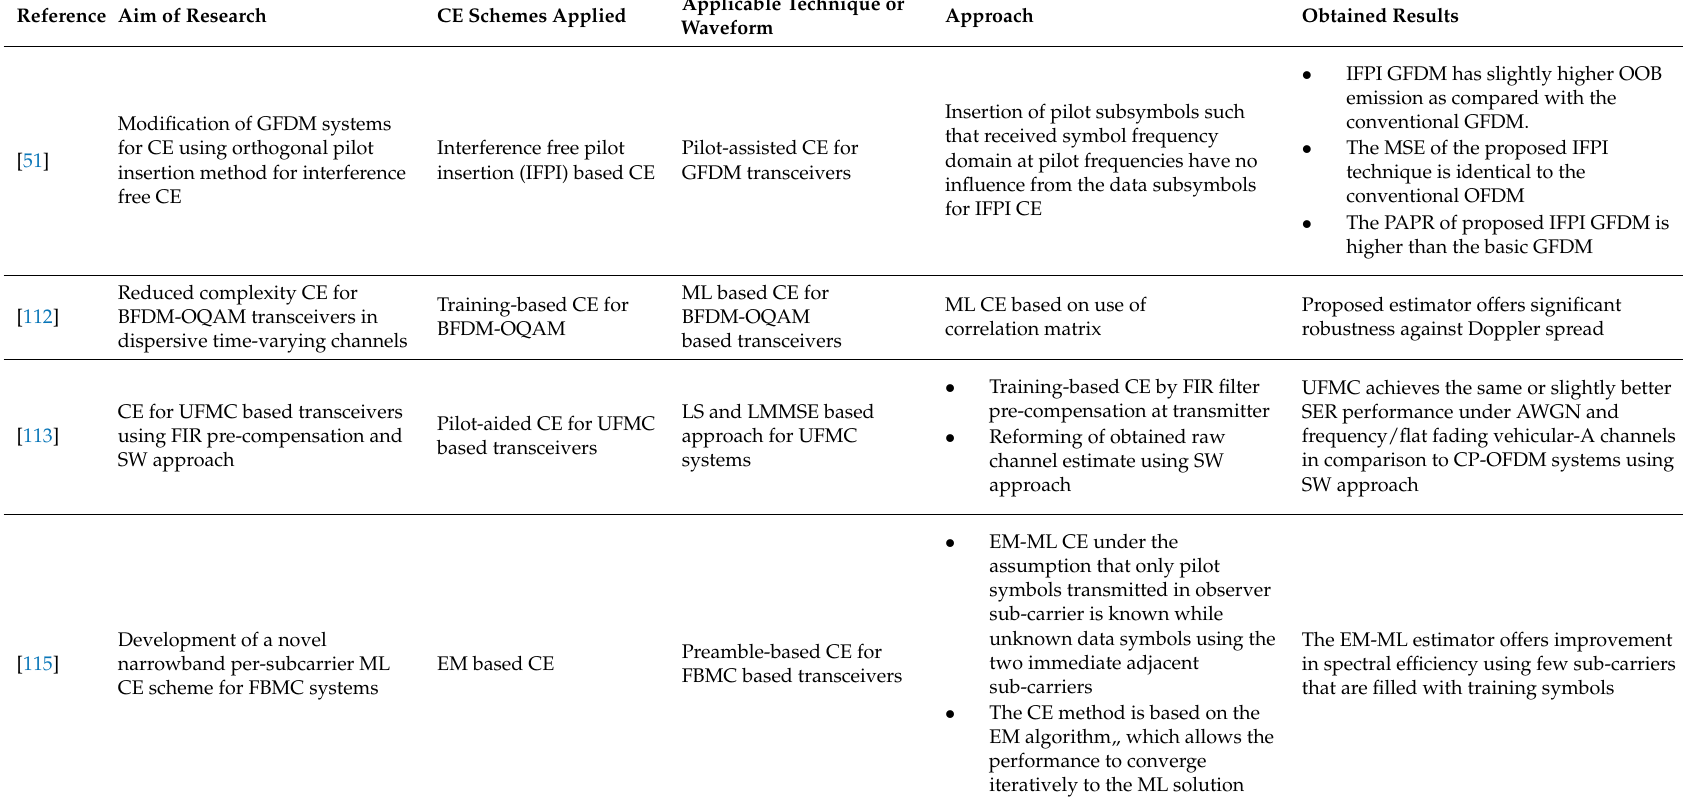
Table 4. Summary of CE techniques for filter bank multicarrier modulation